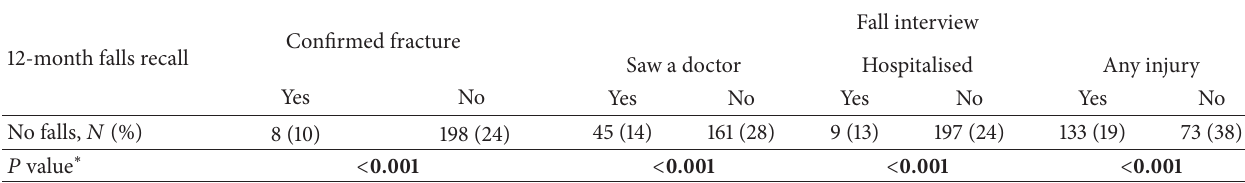
Table 4: 12-month falls recall according to injury or health care